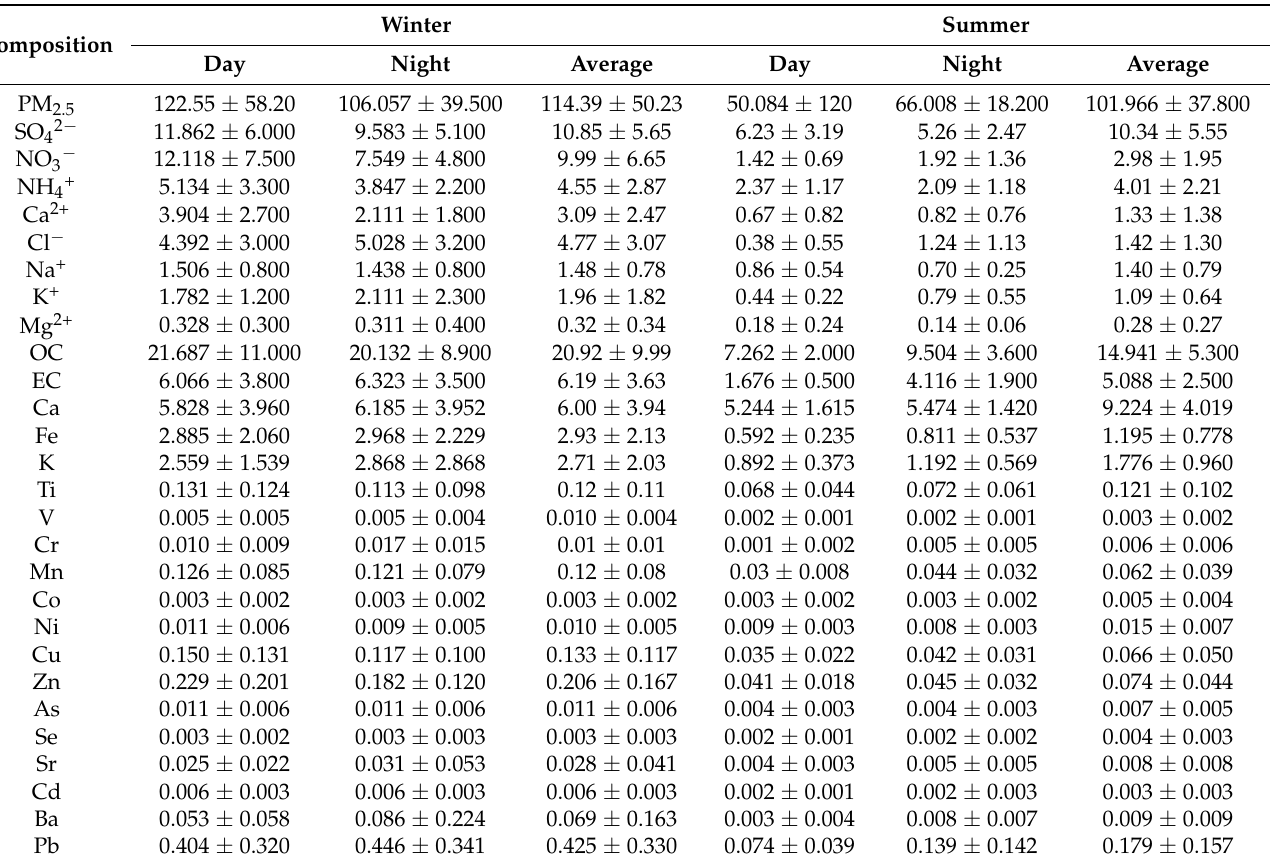
Table 1. The average concentration of PM 2.5 and its chemical composition during the day and at night in winter and summer ( µ g/m 3